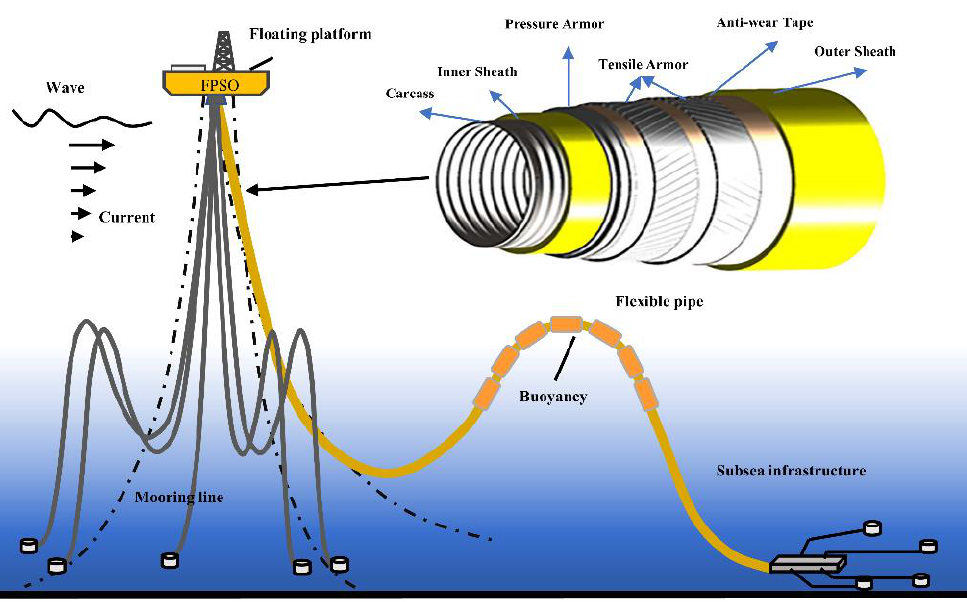
Figure 1. Floating production system and flexible pipe.